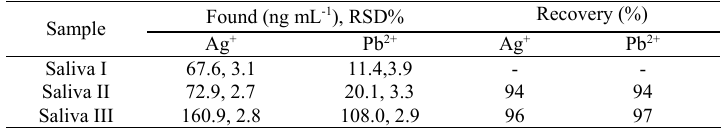
Table 2: Results for the determination of targeted of Ag + and Pb 2+ ions in saliva samples Sample